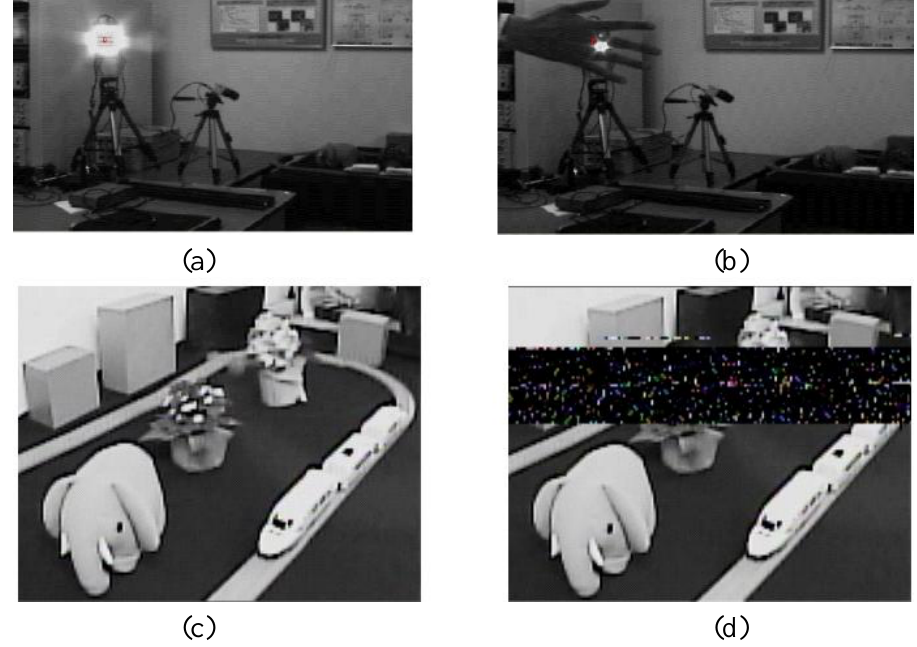
Figure 25. Image output of the prototype chip and reproduced